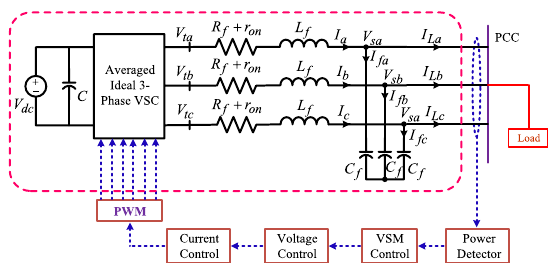
Fig. 6 Diagram of VOC implementation